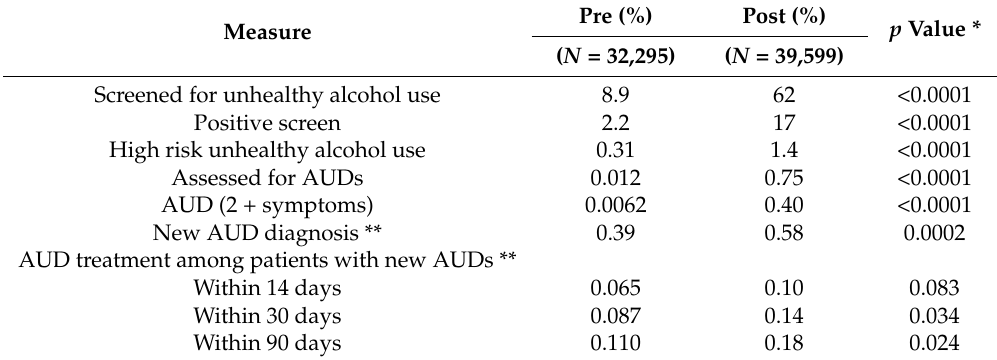
Figure 4 . New diagnosis and treatment for alcohol use disorders (AUD): percentage (%) of visits by month, among providers implementing Behavioral Health Integration including the Sustained Patient-centered Alcohol-related Care (SPARC) program within three PC sites. Table 3. Changes in rates of alcohol screening, AUD symptom assessment, new diagnosis, and treatment of AUDs Pre- versus Post-Behavioral Health Integration (which includes the SPARC